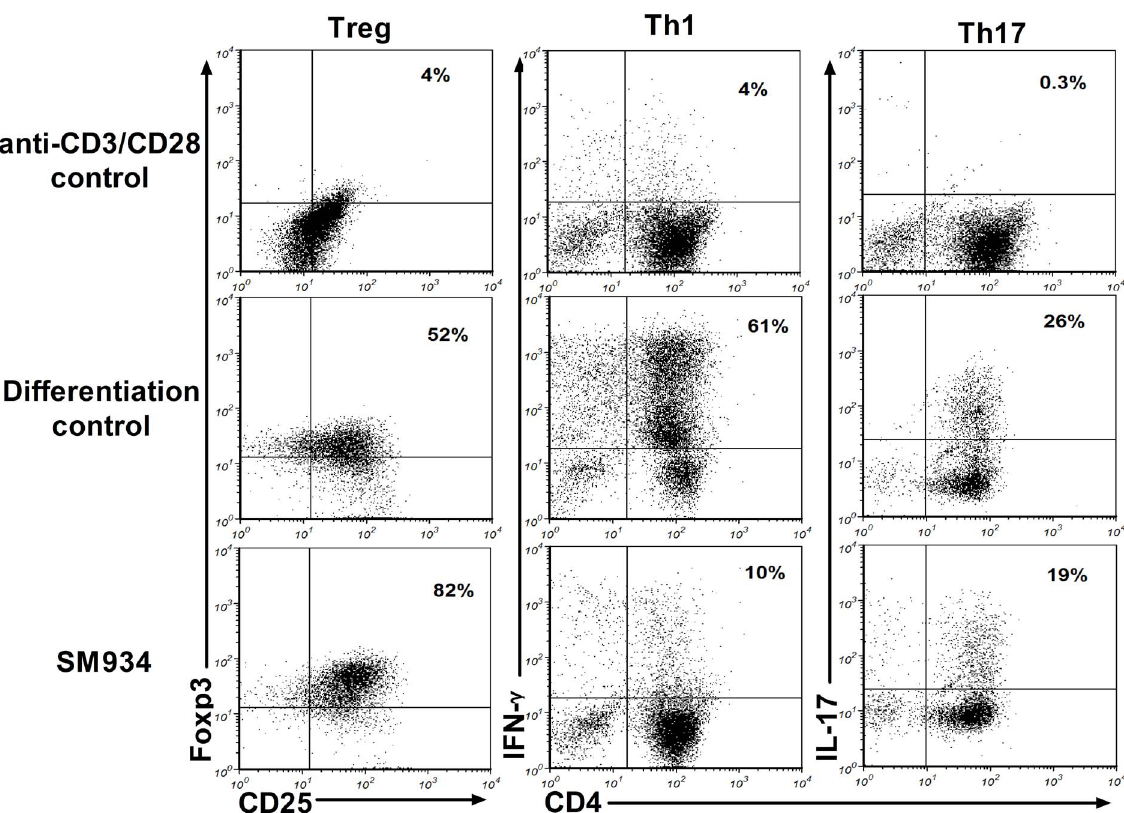
Figure 6. SM934 regulated Th cell differentiation invitro . Naı¨ve CD4 + T cells in spleens were purified by immunomagnetic positive selection from normal C57BL/6 mice, and cultured in Treg, Th1, Th17 cells differentiation conditions for 96 hours, with or without SM934 (1 m M). Frequencies of Treg, Th1 and Th17 were quantified using flow cytometry. Three independent experiments were performed with similar results.